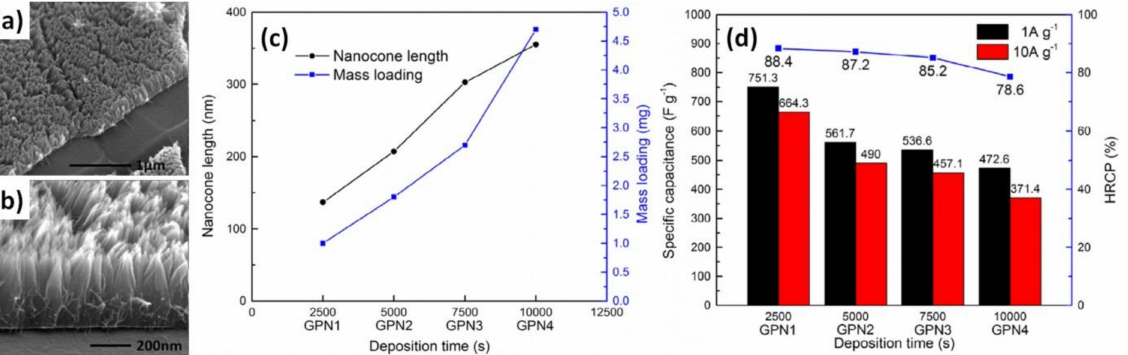
Figure 14. Microstructure of vertically aligned PANI nanocone arrays on the surface of 3D graphene ( a , b ). Mass loading of PANI and length of nanocones vs. electrodeposition time ( c ). Specific capaci- tance and high-rate capacitance percentage (HRCP) of GPN1-4 ( d ) (Reprinted from [50], Copyright 2015, with permission of